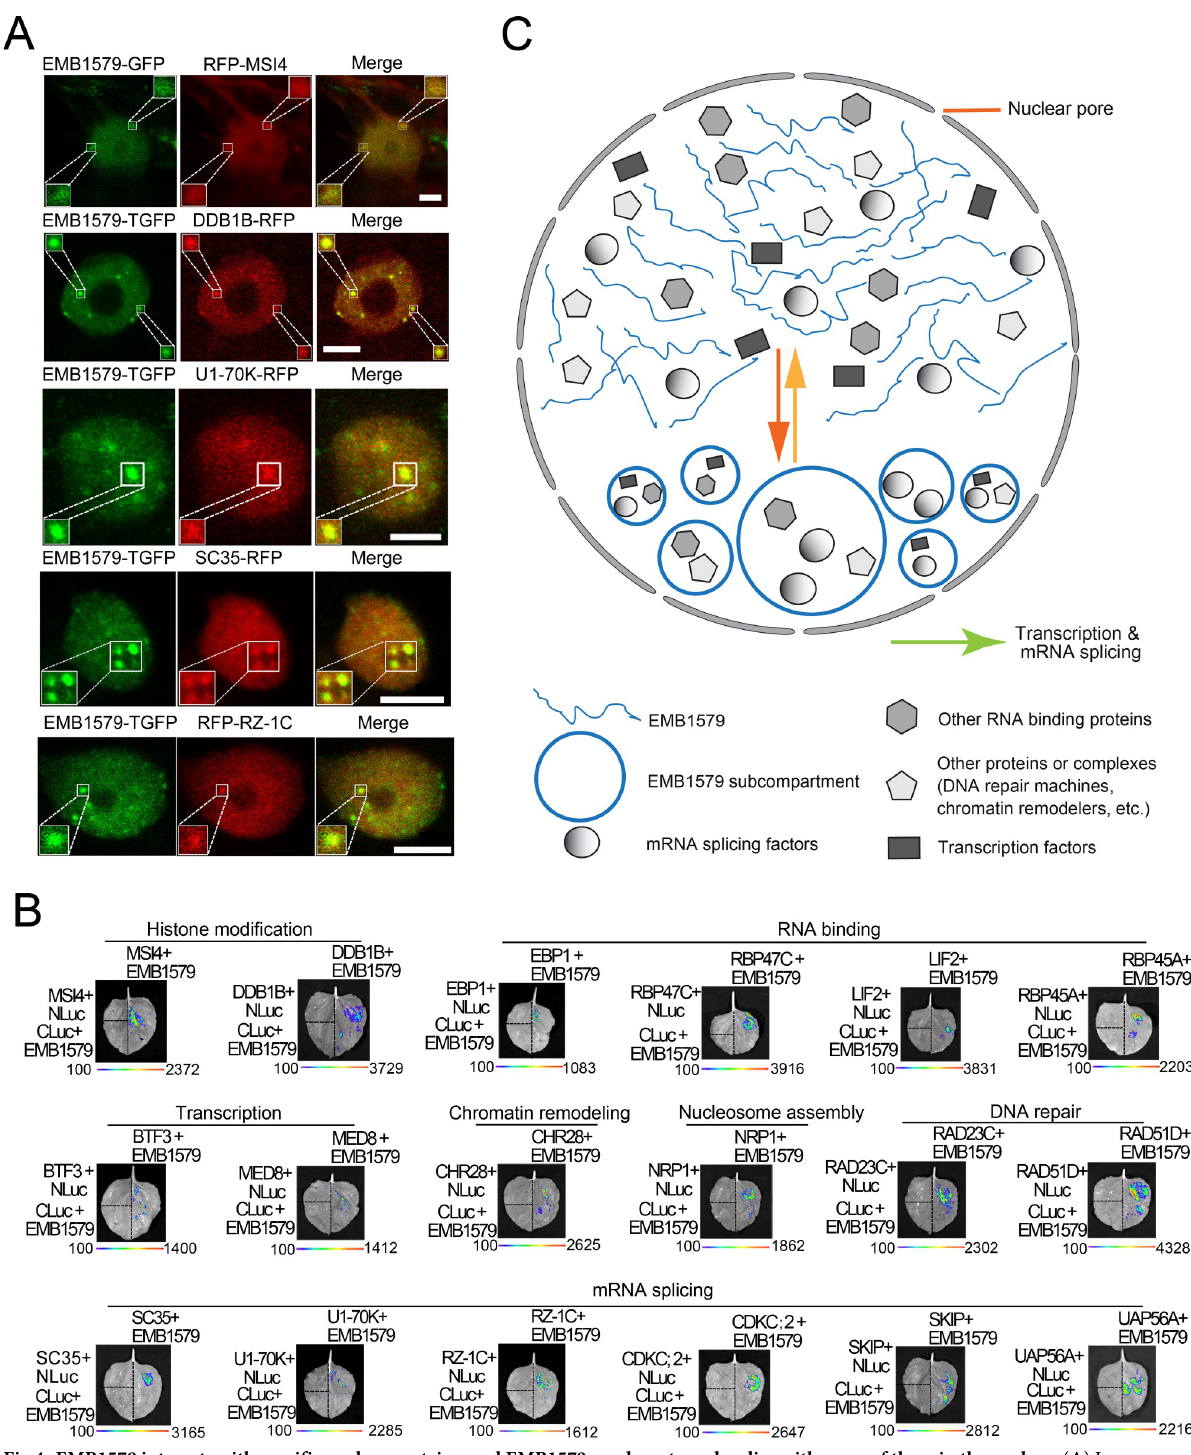
Fig 4. EMB1579 interacts with specific nuclear proteins, and EMB1579 condensates colocalize with some of them in the nucleus. ( A ) Images showing colocalization of some nuclear proteins with EMB1579 condensates. The colocalization experiment of MSI4 with EMB1579 was performed in leaf epidermal cells of Nicotiana benthamiana , and the colocalization experiments of other nuclear protein with EMB1579 were performed in Arabidopsis root cells. Bars = 5 μ m. ( B ) Firefly split luciferase complementation imaging assay confirms that 15 nuclear proteins identified by mass spectrometry analysis (Fig 3A) and three colocalized proteins directly interact with EMB1579. ( C ) Simple model for the phase separation of EMB1579 in the nucleus and its potential functions in Arabidopsis . EMB1579 undergoes phase separation to form dynamic compartments in the nucleus. The